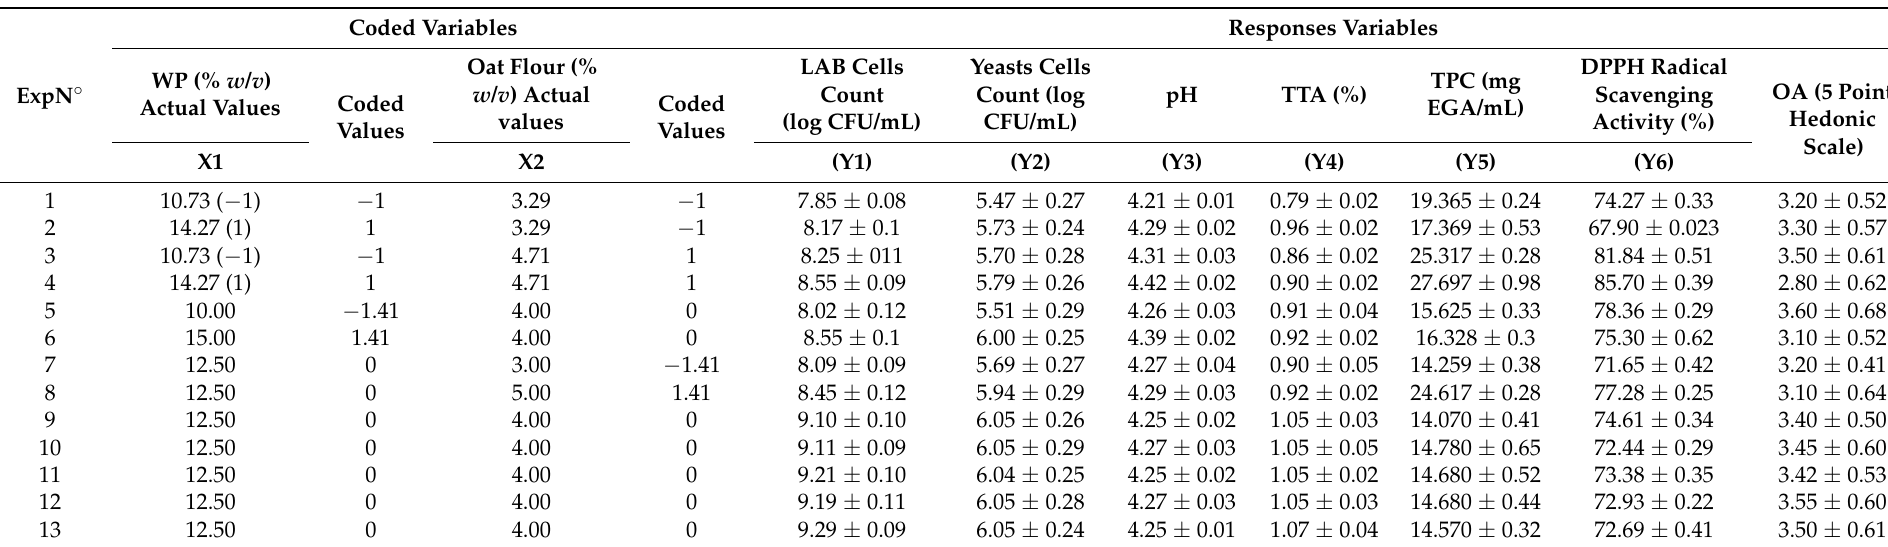
Table 2. Matrix of the central composite design (CCD) and observed responses to the percentages of WP and OF for the response variables (lactic acid bacteria (LAB) and yeasts cells